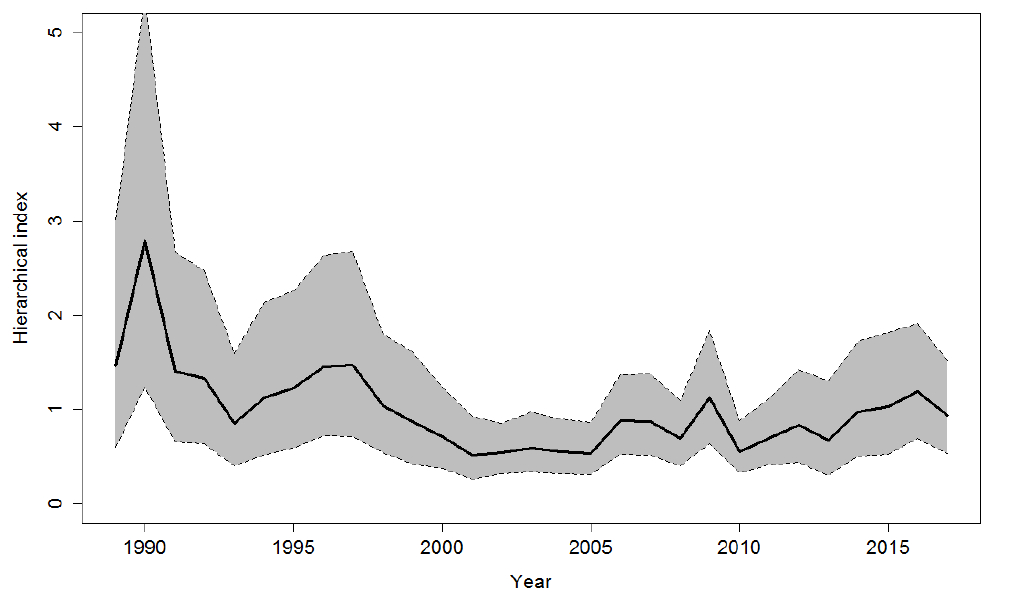
Figure 79. Time series of horseshoe crab relative abundance in the Delaware Bay region as estimated from the hierarchical analysis. The black line gives the posterior mean and the grey, shaded area represents a 95% credible interval about the time series.